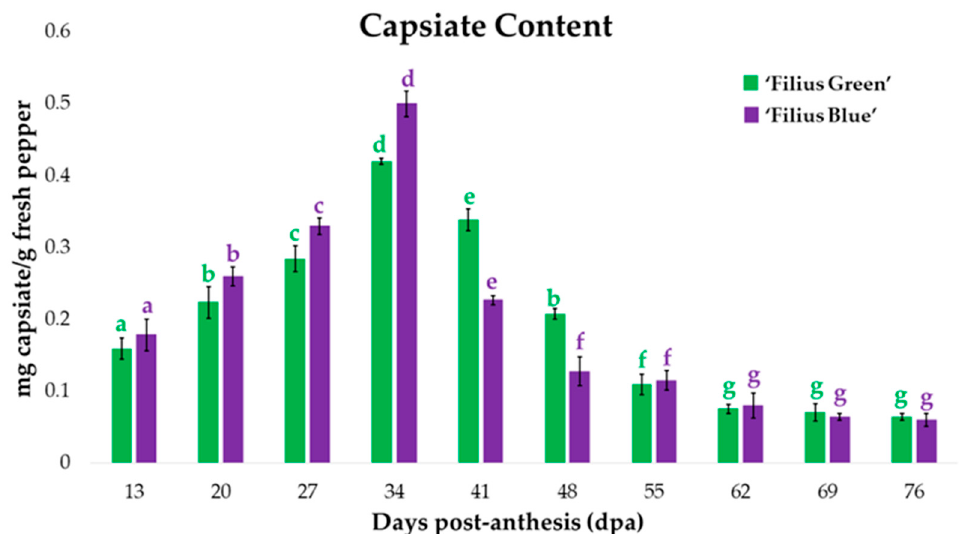
Figure 5. Capsiate concentration (mg g − 1 FW) during fruit ripening ( n = 2). The same letter assigned to each variety in this figure indicates that there were no significant differences in capsaicinoids content according to Tuckey’s test, that is, both values have a p -value > 0.05. In addition, a different letter color has been assigned to each specific variety, i.e., green for ‘Filius Green’ and purple for ‘Filius Blue’.